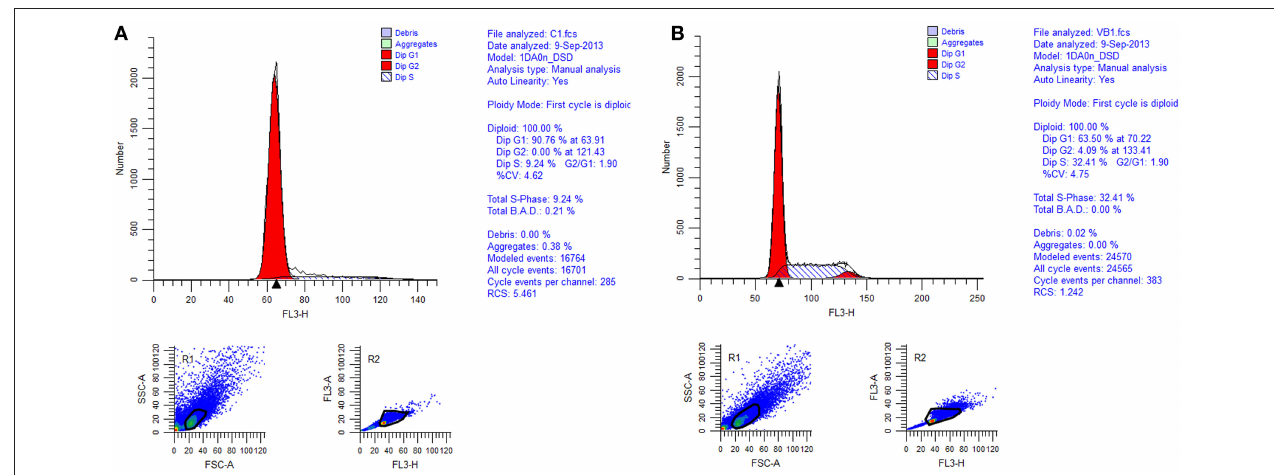
FIGURE 2 | Cell cycle identification of cell by flow cytometry. (A) control cell; (B) REV infected cell.